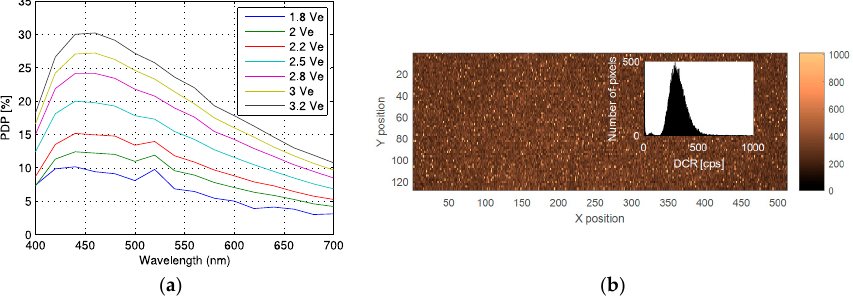
Figure 8. Pixel characterization: ( a ) PDP vs. wavelength at given excess bias voltages; ( b ) DCR distribution at 40 °C for V e = 4.5 V, with an average of 1169 cps and a median of 302 cps. In the inset the DCR distribution is shown.